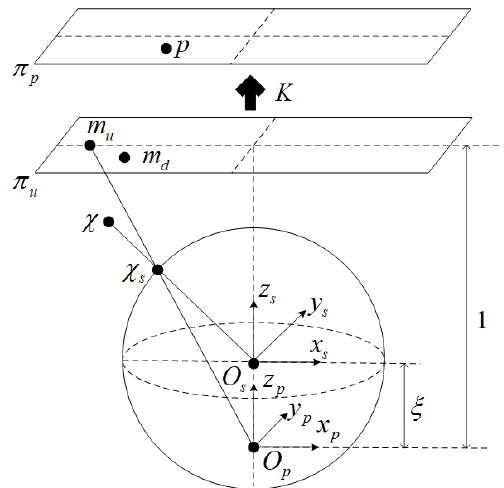
Figure 4. The projection model of an omnidirectional